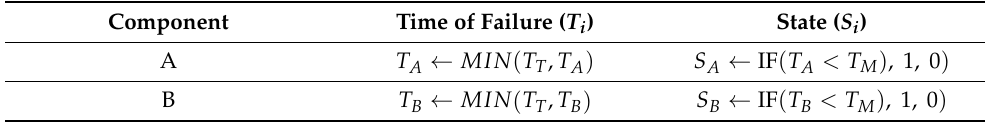
Table 5. Logical expression for deriving the output of an FDEP